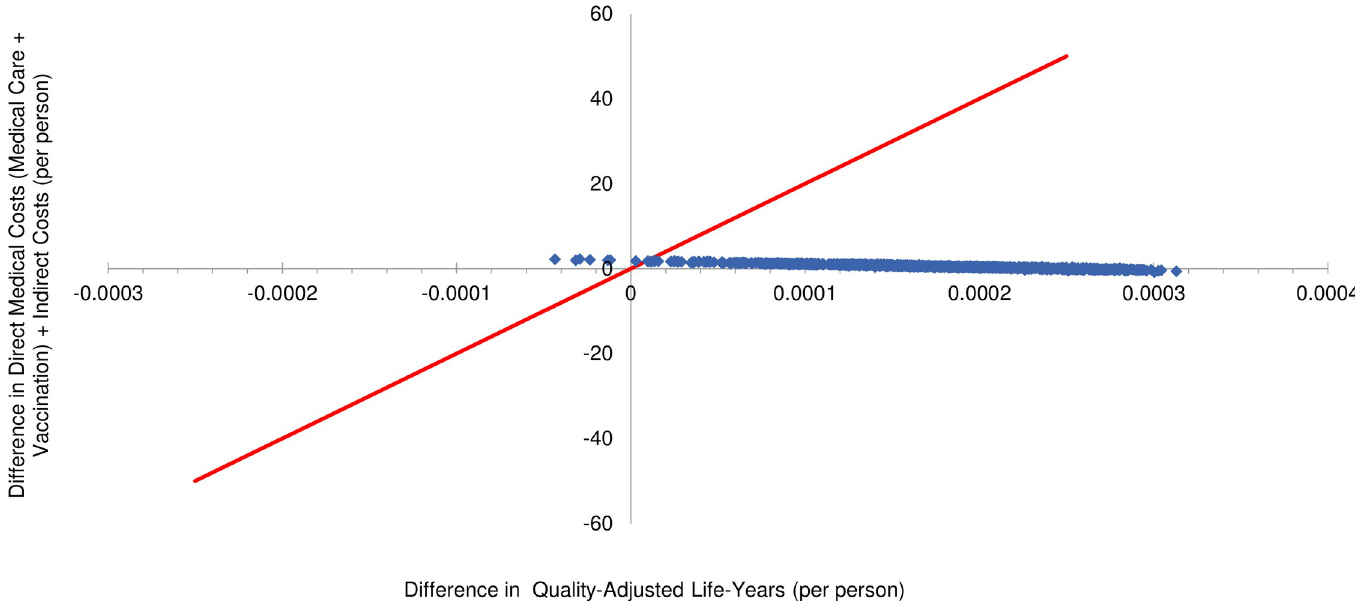
Fig 9. Graphical illustration of PSA for the public health care sector HIV-infected model. Costs are indicated in 2015 South African rand.